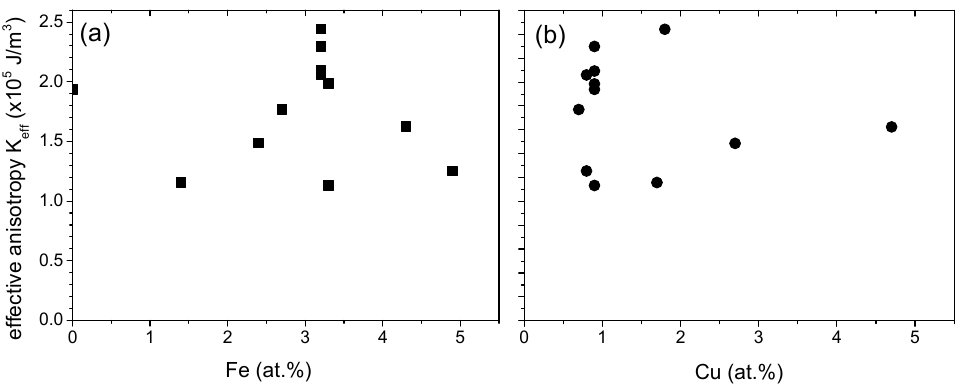
Figure 4. Effective magnetic anisotropy as a function of alloying elements ( a ) Fe ( b ) Cu in Ni ‐ Mn ‐